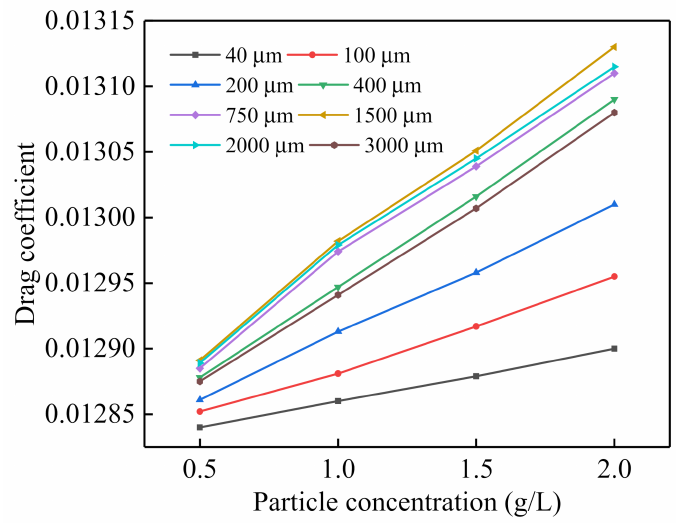
Figure 20. The effect of particle concentration on the airfoil lift